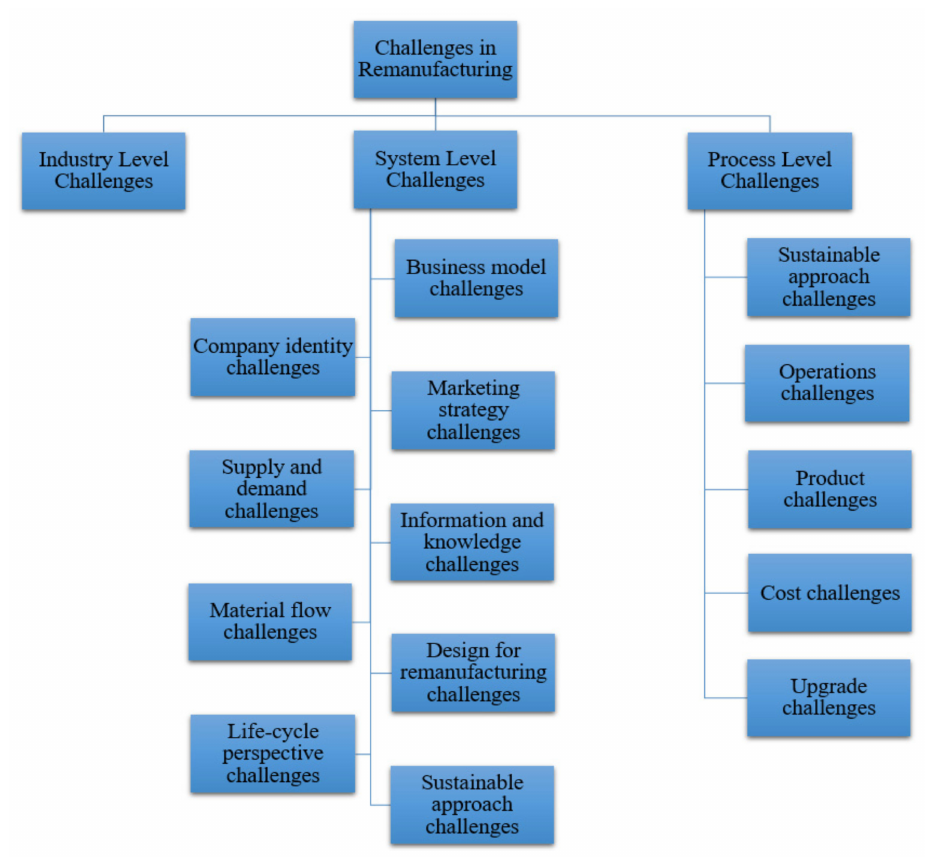
Figure 6. Challenges in remanufacturing as identified by Kurilova-Palisaitiene et al.